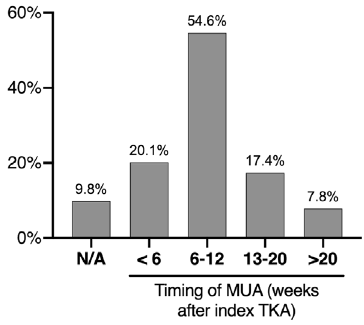
Figure 3. Results of the survey question: How many Total Knee Arthroplasties do you perform annually?